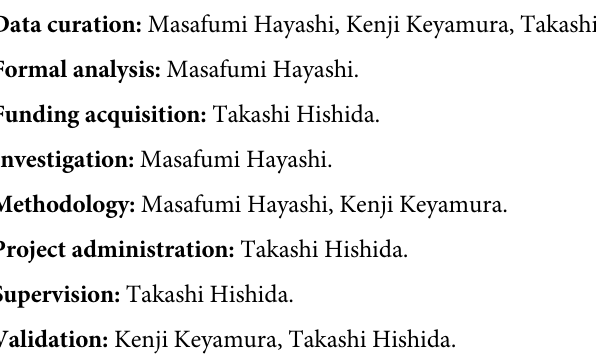
130 residue is indicated by arrow. (B) A schematic representation of the secondary structure map of Rad5 N-terminal region. Feature predictions by DISOPRED are color coded onto the sequence according to the sequence feature key shown below.